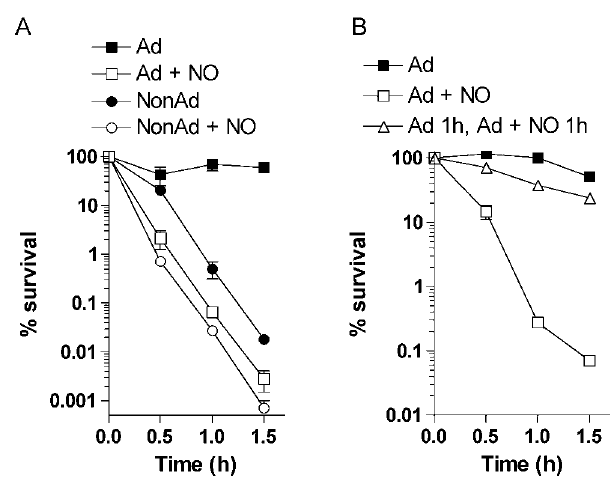
Figure 2. RNS inhibit the Salmonella ATR. The susceptibility of adapted (Ad) and nonadapted (NonAd) Salmonella cultures to acid challenge in EG medium, pH 3.0 was determined as described in figure 1. (A) Selected groups of Ad and NonAd bacterial cultures were treated with 250 m M spermine NONOate (NO) for 2 h before acid challenge. (B) The acid sensitivity of Ad and Ad + NO Salmonella was compared to controls grown for 1 h in EG medium, pH 4.4 before exposure to 250 m M spermine NONOate for 1 h (Ad 1 h, Ad + NO 1 h). The data represent the mean 6 SEM of 4–8 independent observations from 2–3 separate